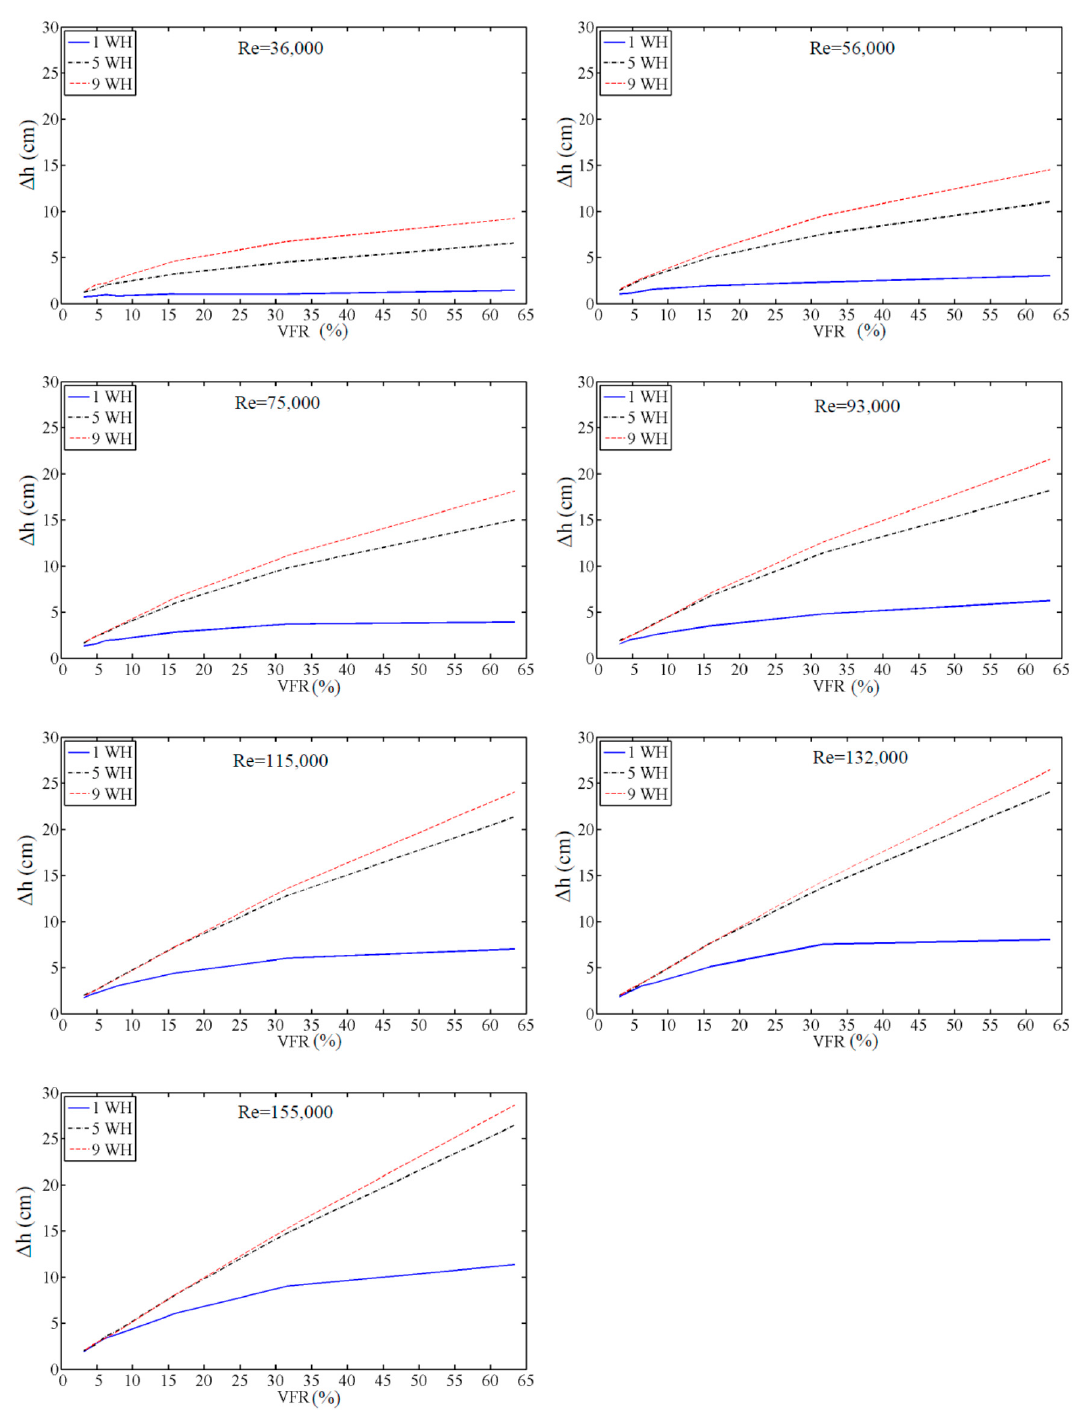
Figure 9. Water level change ( Δ h) in the CAV against the VFR for different Re.